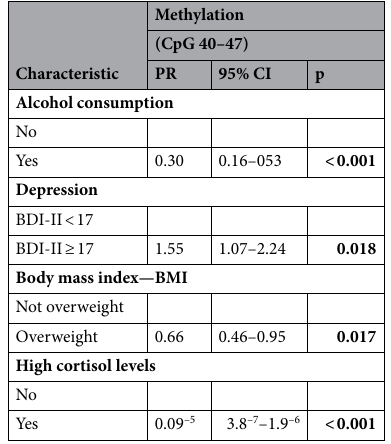
Table 4. Multivariate Poisson regression analysis with robust variance for methylation of NR3C1 1F region. Bold values indicate significance result. PR prevalence ratio, 95% CI confidence interval, p p value.